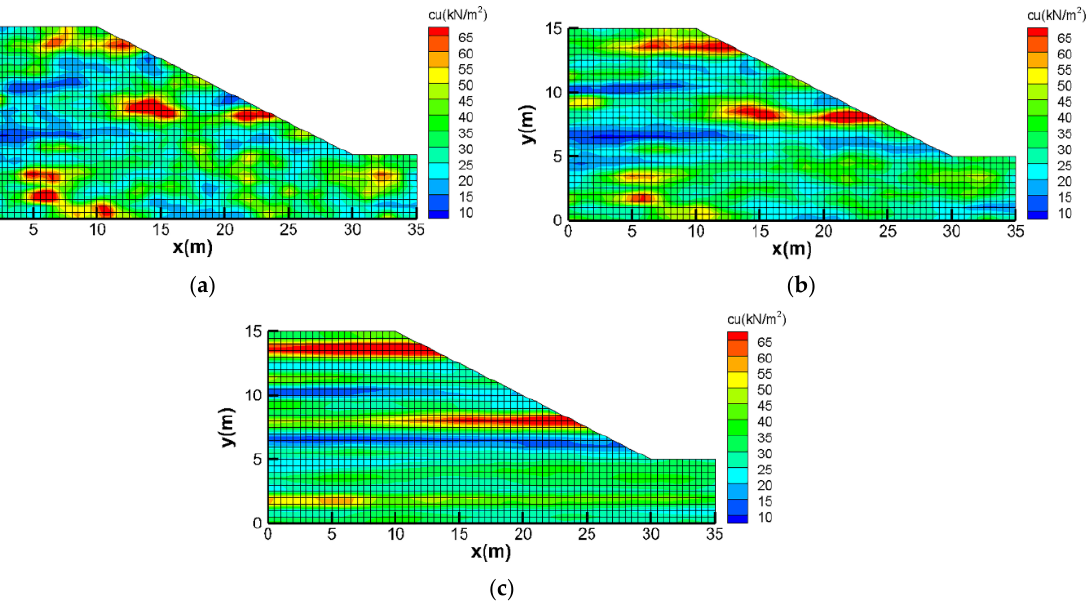
Figure 2. Numerically generated statistically anisotropic undrained shear strength fields ( λ x > λ y ):